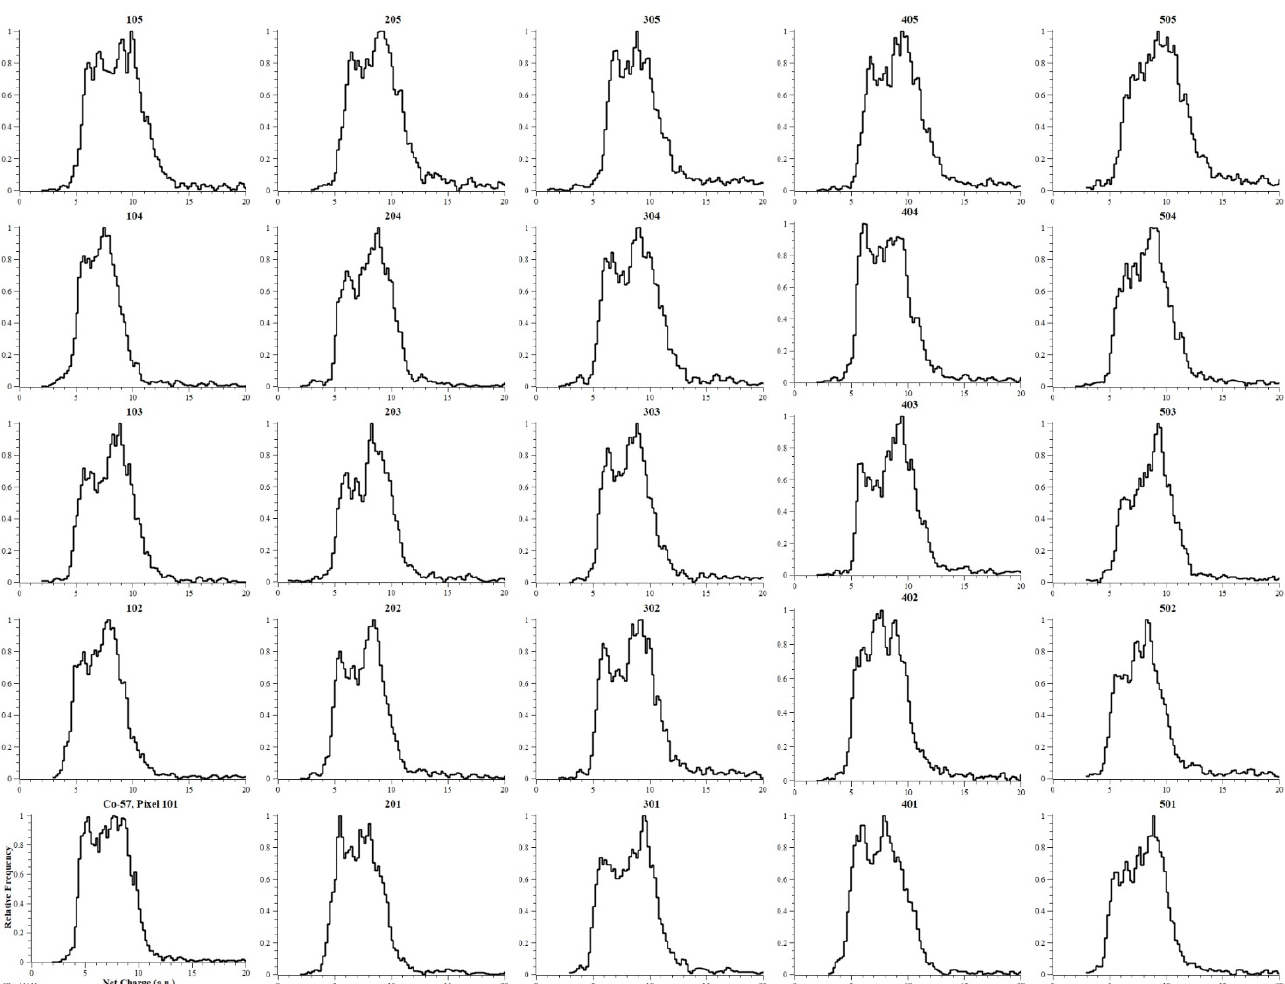
Figure A1. Co-57 pulse-height spectra per crystal-pixel for the first quarter of the array which includes the pixels with RR ≤ 5 and CC ≤ 5. The common axes and plot descriptions are only once in the bottom-left frame for better clarity. Spectra have undergone denoising smoothing, and were built by using 0.2 ch.u. binning. Frequency values were normalized, pixel by pixel, to the respective maximum value.